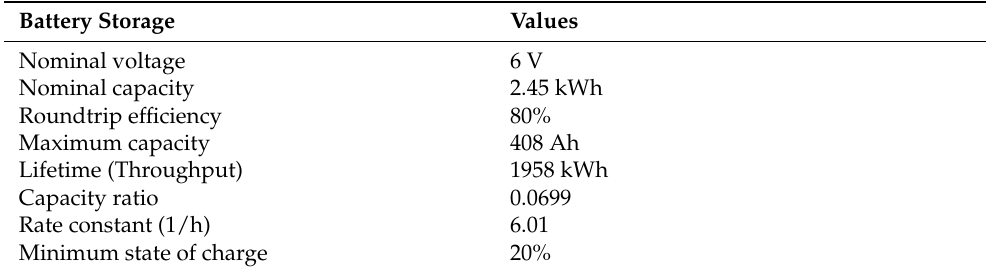
Table 11. Technical details of the selected